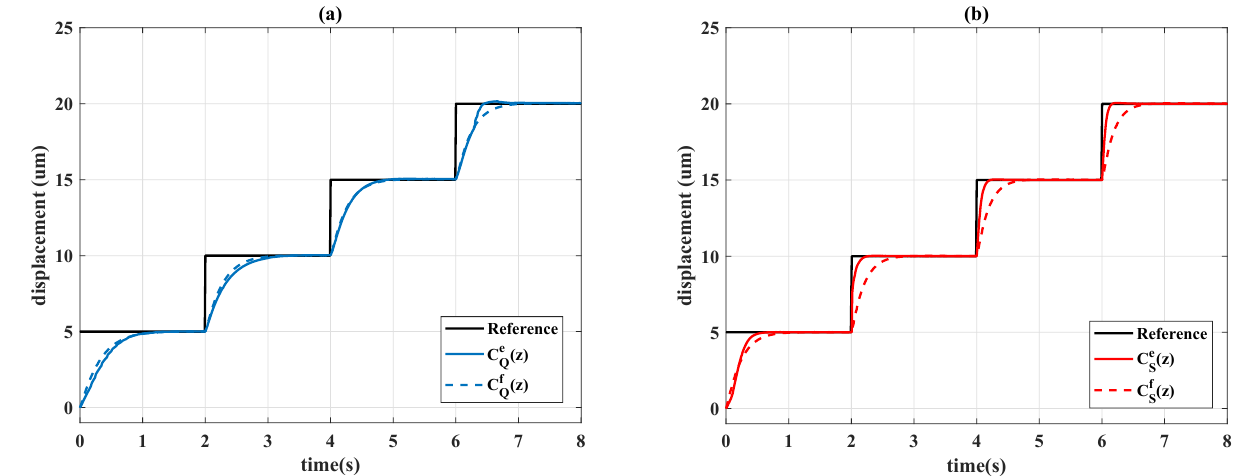
Figure 14. Output responses of: ( a ) Q-learning controllers; ( b ) Sarsa controllers.